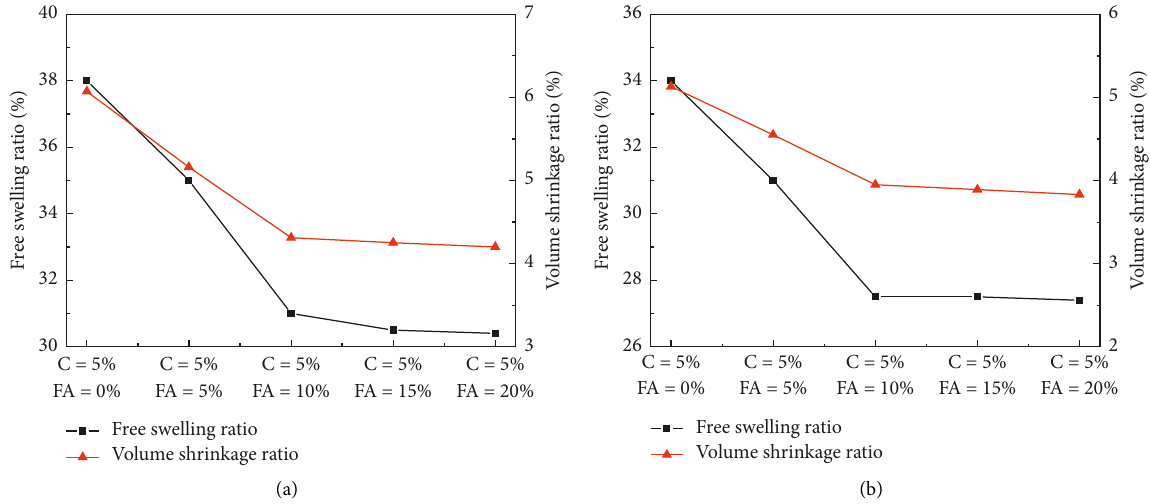
Figure 6: Swelling-shrinkage behaviors of cement-fly ash-stabilized soil under different curing periods. (a) 7 days. (b) 28 days.